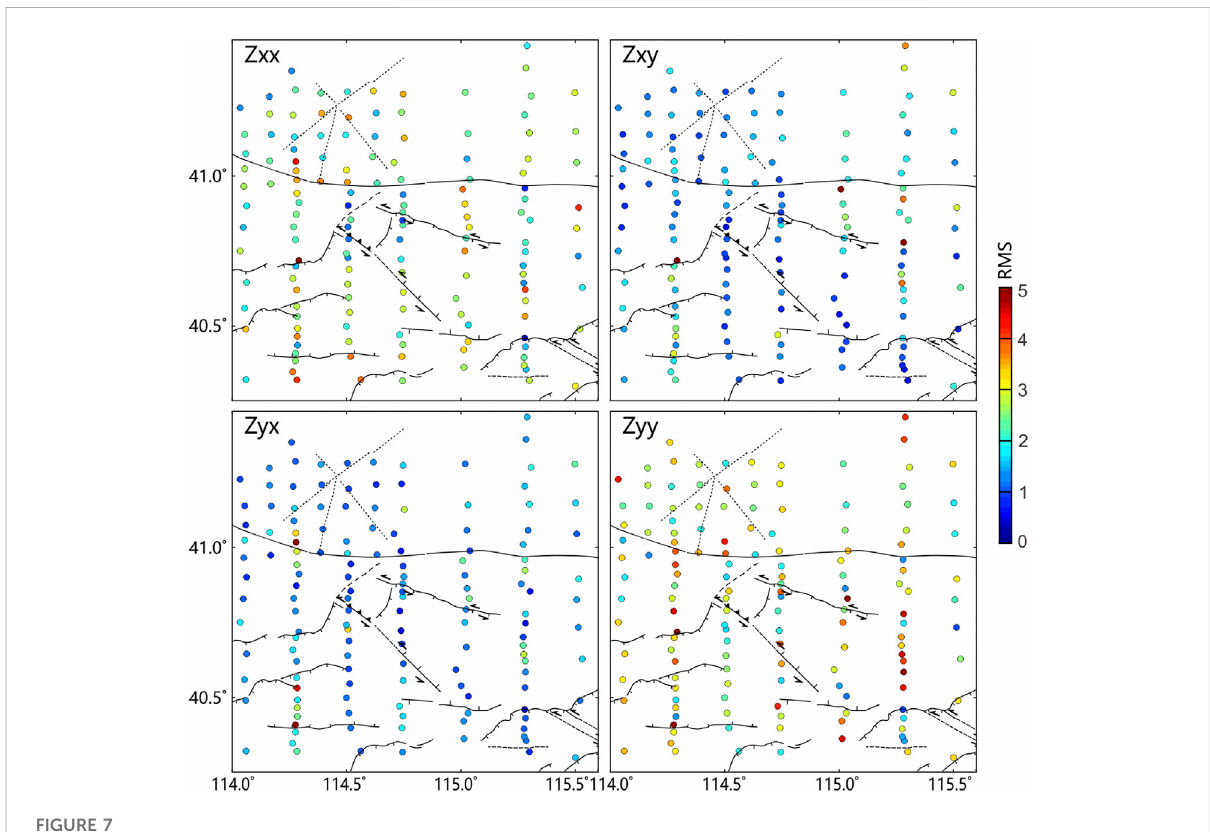
FIGURE 7 The four component RMS mis fi t at each